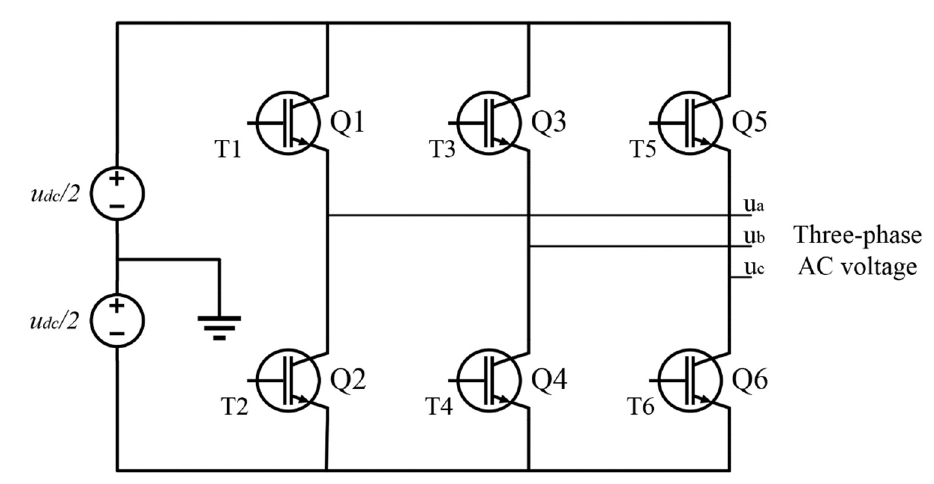
Figure 6. Inverter model.